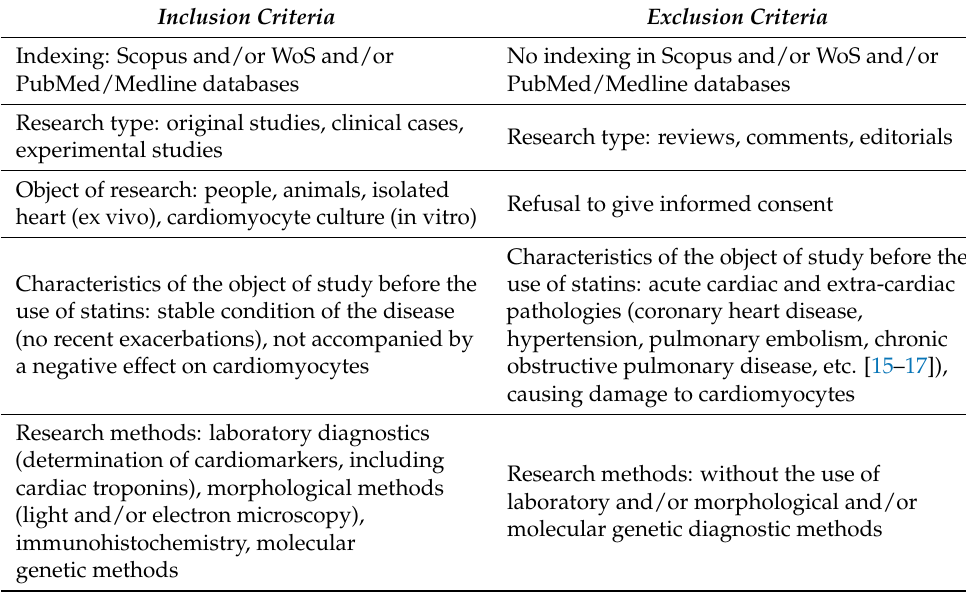
Table 1. Criteria for inclusion and exclusion of articles for